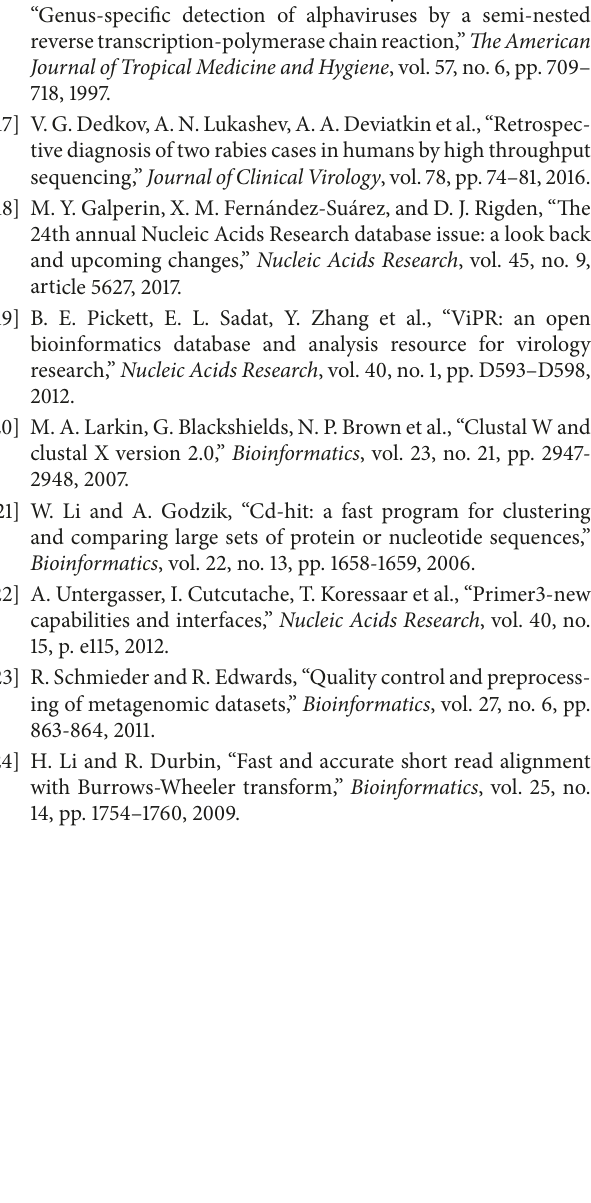
Table S1 : mean, median, and 10th and 90th percentiles of read lengths distributions for unfiltered FASTQ